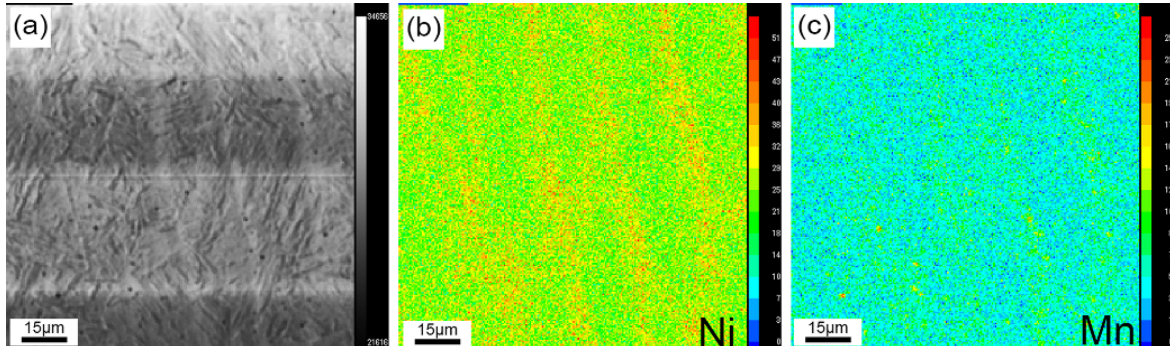
Figure 4. The elements distribution in the deposited metal of Ni7.5 revealed by EPMA. ( a ) microstructure of deposited metal; ( b ) distribution of nickel (Ni); ( c ) distribution of manganese (Mn).